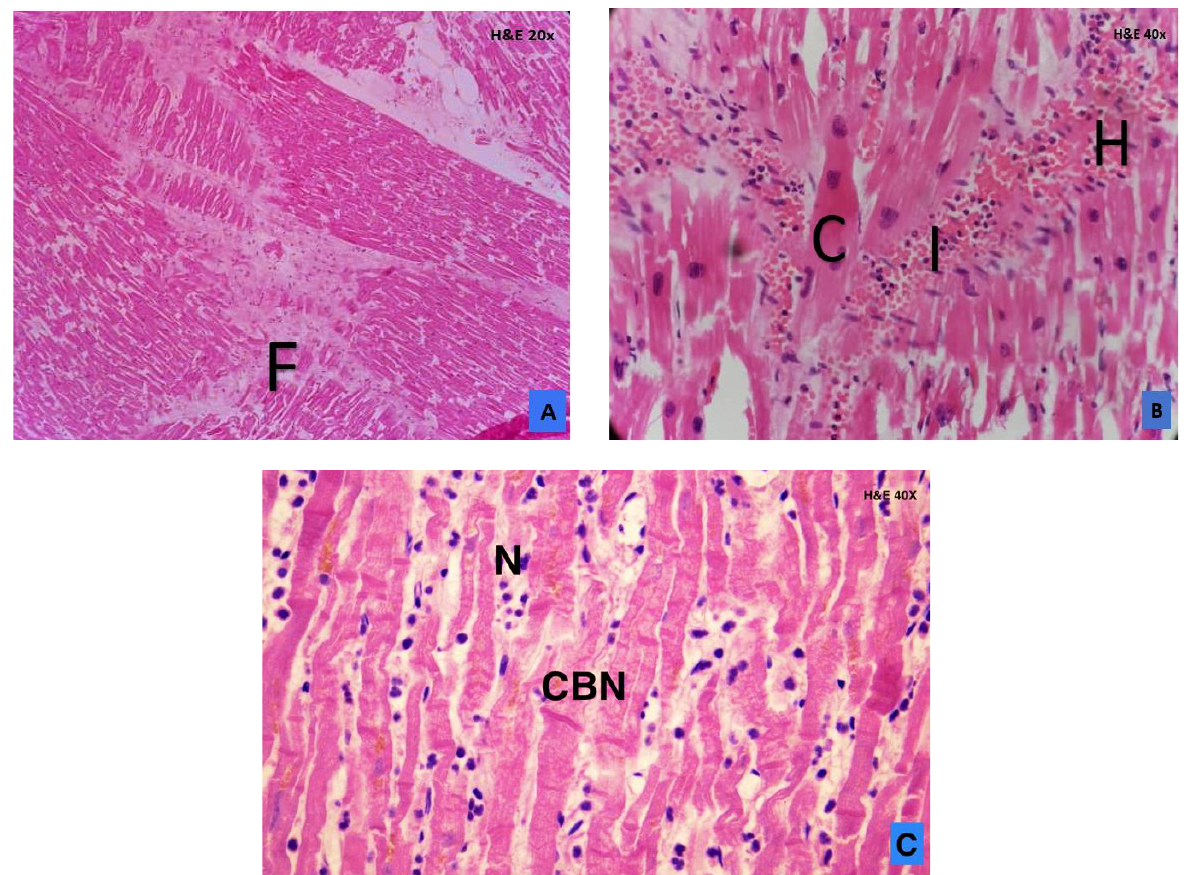
Figure 1: Heart tissue taken during autopsy and stained with haematoxylin and eosin (H&E) staining. (A) Replacement fibrosis (F) of the myocardium. (B) Inflammatory cells predominantly neutrophil (I) infiltration into the myocardial interstitium and adjacent haemorrharge (H) with a background of cardiomyocytes hypertrophy (C). (C) Neutrophils (N) infiltration into interstitium with a background of myocardial necrosis and contraction band necrosis